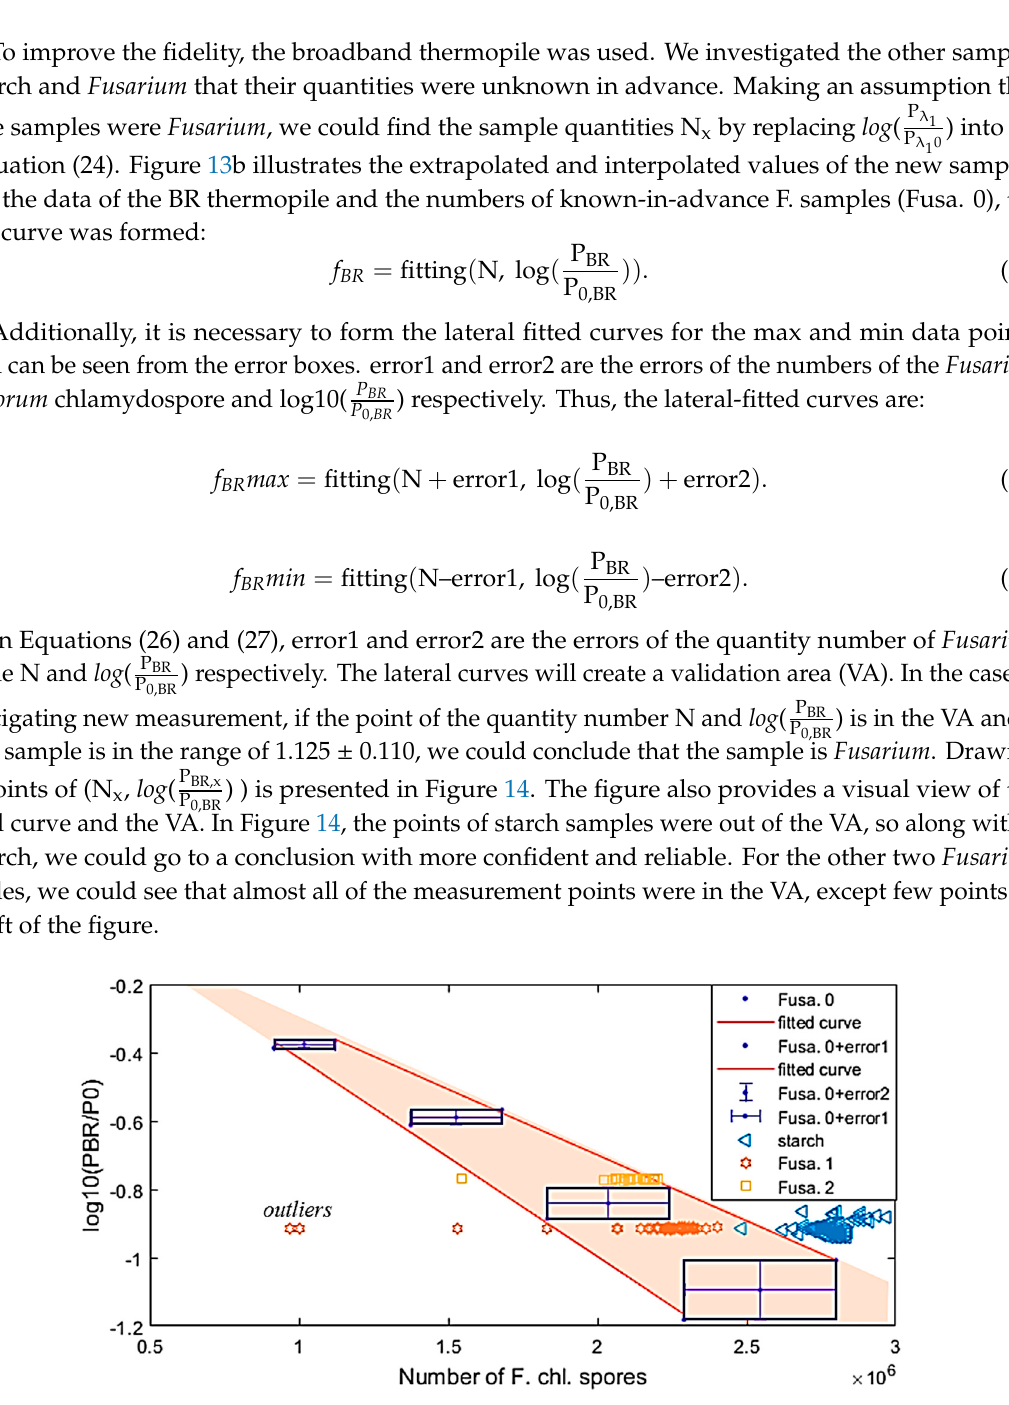
)) and the validation area formed by the lateral curves of Equations P 0,BR (cid:2900) (cid:3116),(cid:3134)(cid:3150)